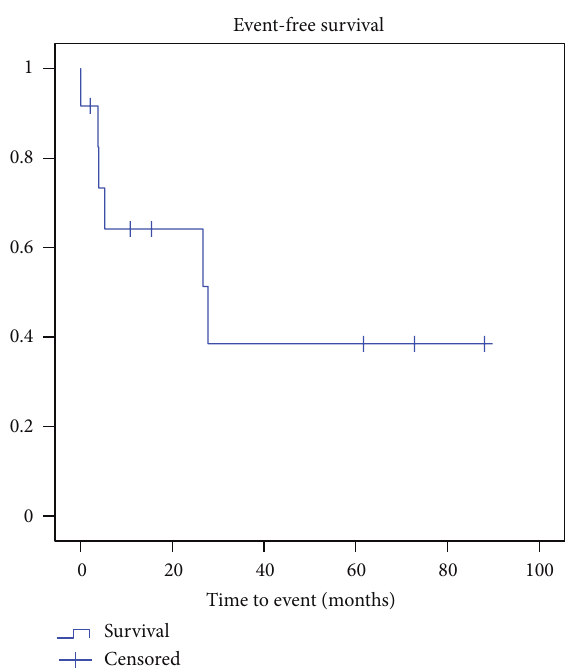
Figure 2: Kaplan-Maier curve for event-free survival, with event